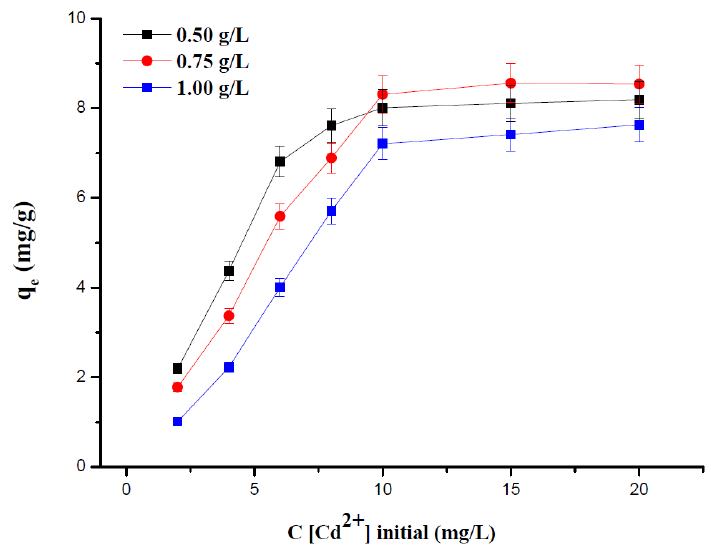
Figure 10. The initial concentrations of Cd 2+ as a function of SNPs dosage (T = 30 °C, pH = 5).